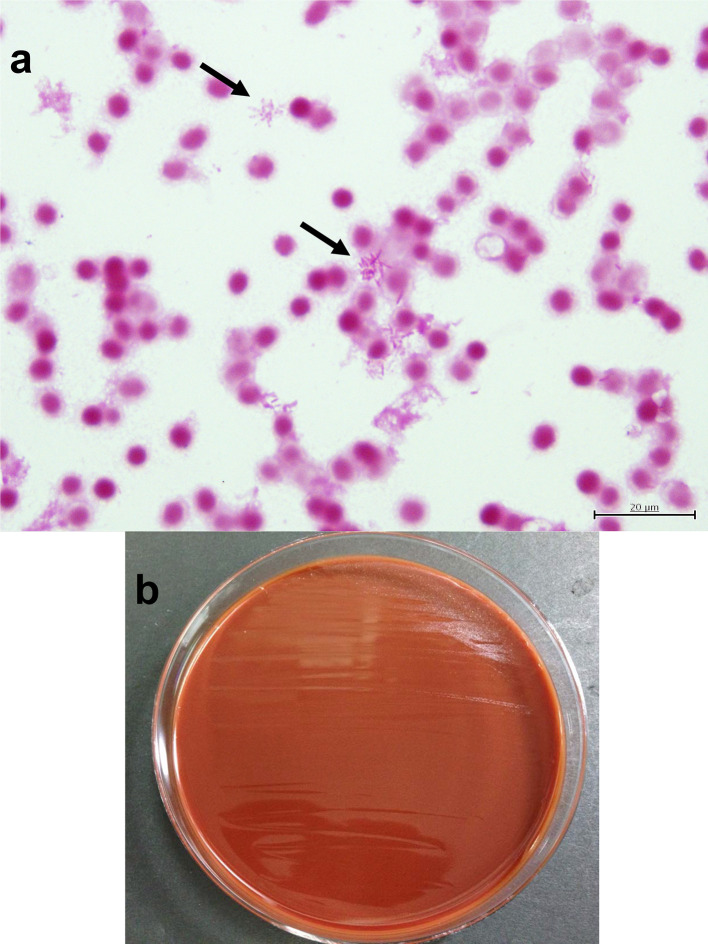
(a) Smear photograph of bacilli isolated from a blood culture sample obtained on the day of admission. We identified the causative organism based solely on an aerobic culture bottle that yielded a positive result on the fifth day in hospital. We also performed direct staining of the culture bottle contents using Bartholomew and Mittwer’s method, which revealed slightly elongated and mildly stained Gram-negative bacilli with a rosette formation (black arrows). (b) Isolation of colonies from the blood culture sample. The colonies grew slowly, but we were able to isolate a few tiny white colonies, with a diameter of 0.1 mm, after 72 h of capneic culture.